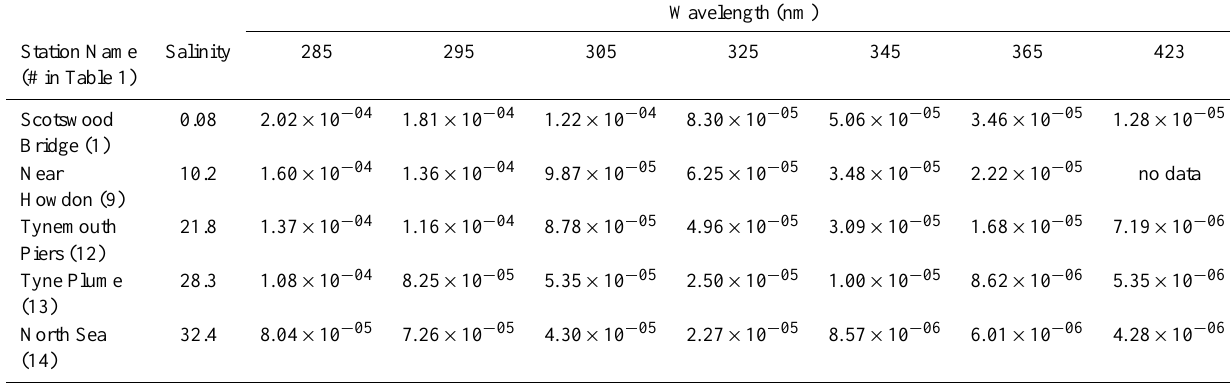
Table 2. Carbon monoxide apparent quantum yields for Tyne estuary samples of varying salinity (all samples from 9 April